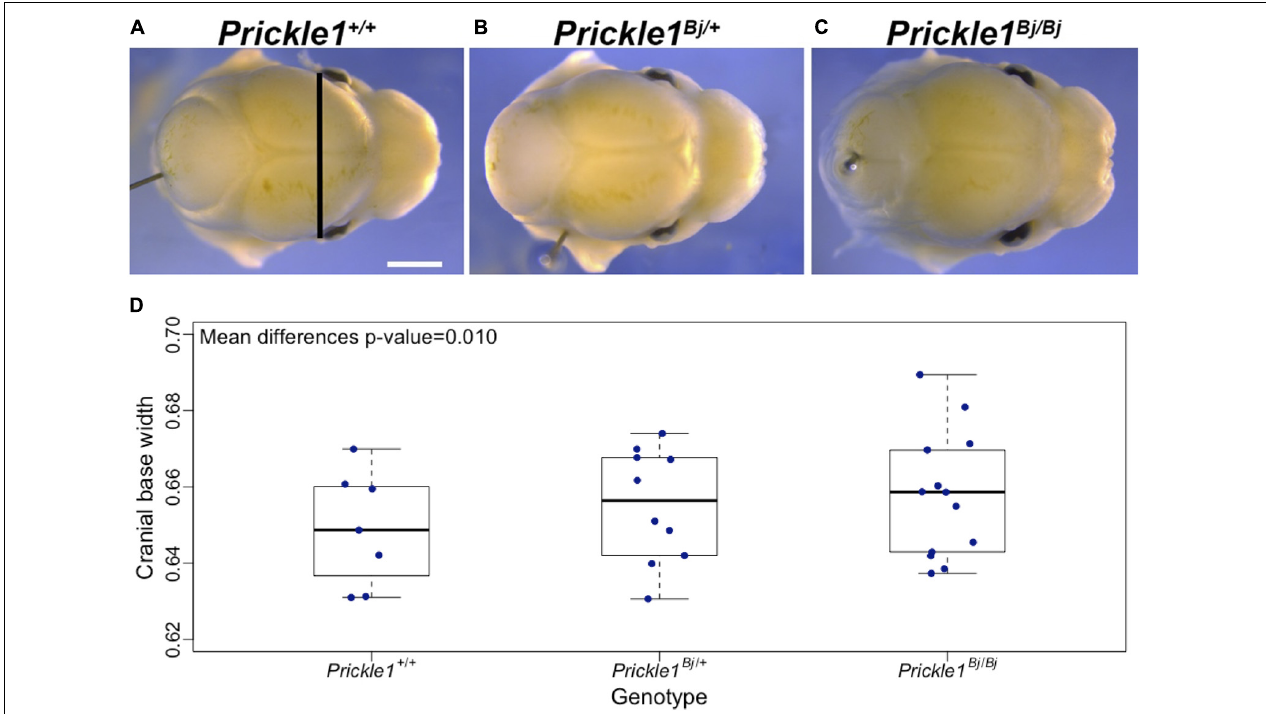
FIGURE 2 | The Prickle1 Bj mouse allele dosage was associated with a wider cranial base. (A–C) Superior views of littermates at embryonic day 14.5 showing craniofacial shape changes in Prickle1 Bj / Bj compared to Prickle1 + / + . Cranial base width measurement is indicated by the black line in (A) . Scale bar , 1 mm (and applies to A–C ). (D) Box plot of the cranial base width. Thick horizontal lines represent group medians. The p -value was obtained from the test of group mean differences assuming an additive genetic model, adjusting for head size and